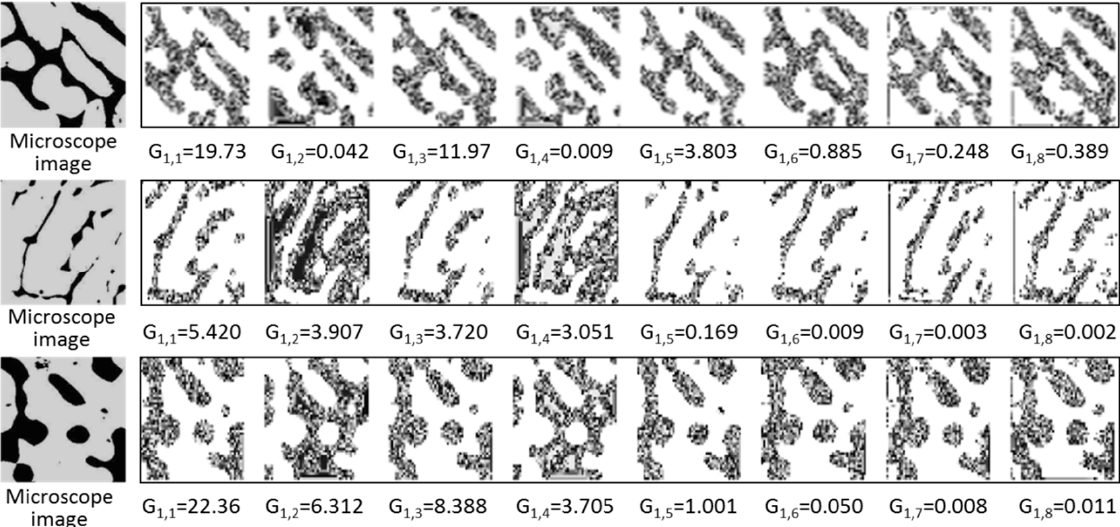
Figure 6. Feature maps of the first eight channels extracted from the last Conv2D block and their Gram matrix values. The left images are microscope images of the samples, the right images are the corresponding feature maps with 50 × 50 pixels in different channels through three Conv2D blocks.